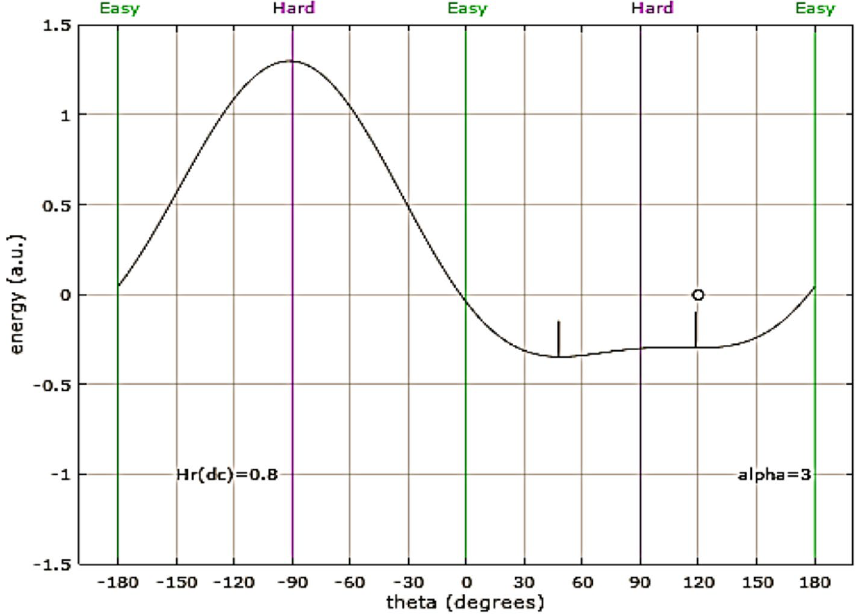
Figure 3. Energy as a function of orientation of magnetization (energy landscape) for an SW-particle with a field of 0.8H k applied 3° from the hard axis. The short, vertical lines show the locations of the minima, while the letter “o” shows the orientation of the magnetization at T = 0 K.